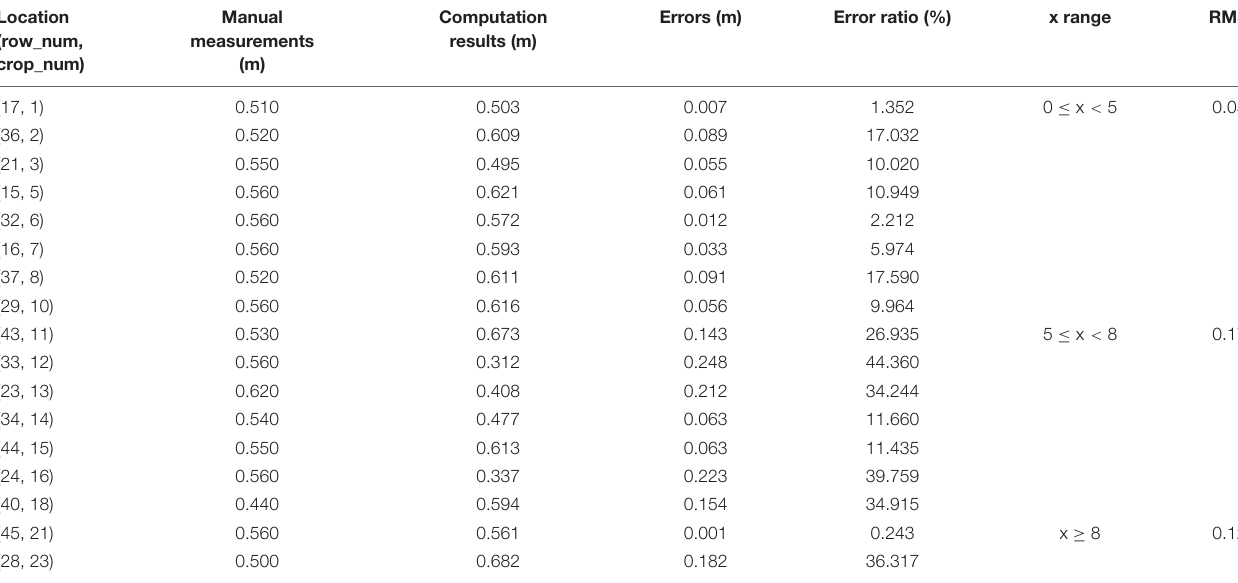
TABLE 6 | Plant height computation results for sub-area B1.